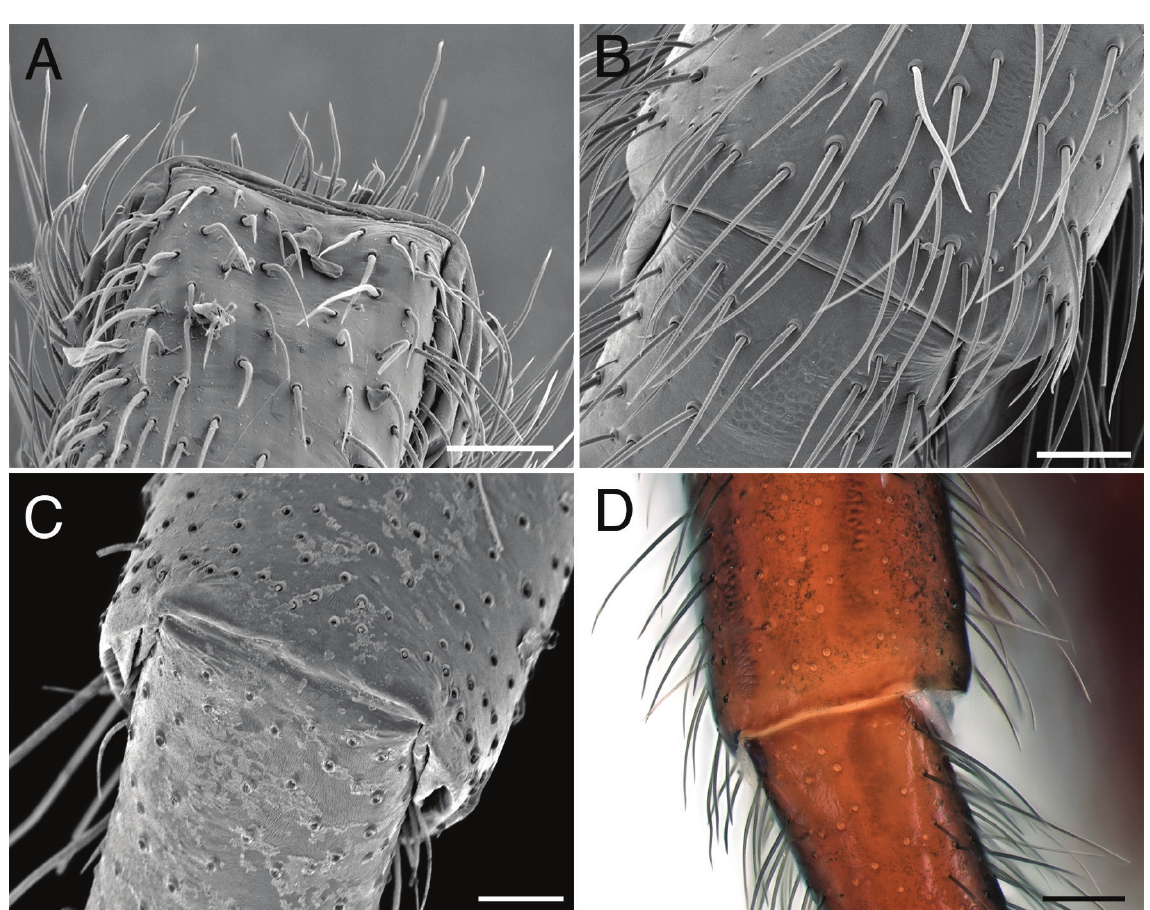
Fig. 21. A . Amaurobius fenestralis (Ström, 1768), ♀, base of right metatarsus 3. B . Coelotes terrestris (Wider, 1834), ♂, right tibia-metatarsus joint III. C . Nurscia albomaculata (Lucas, 1846), ♂, right tibia-metatarsus joint III. D . Penestomus montanus Miller, Griswold & Haddad, 2010, ♀, right tibia- metatarsus joint I. Scale bars: A–B, d = 100 mm, c =